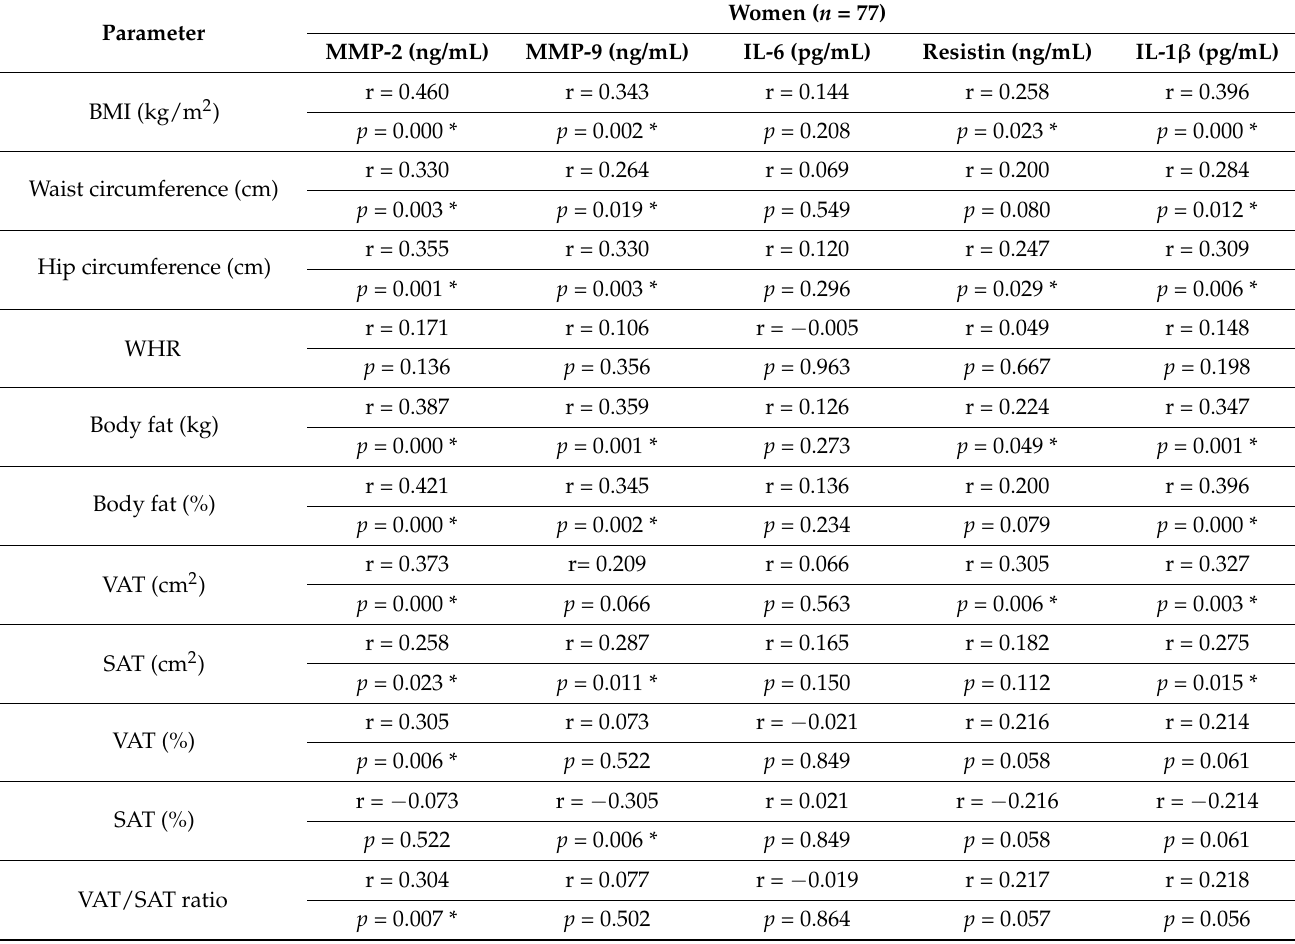
Table 3. Correlations between selected anthropometric/body composition parameters and the concentrations of cytokines/adipokines in the saliva of women from the study and control